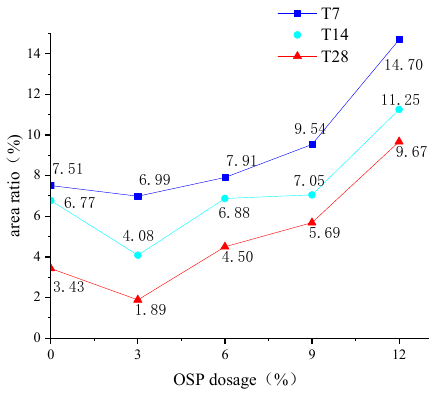
Figure 7. Area ratio of sections.